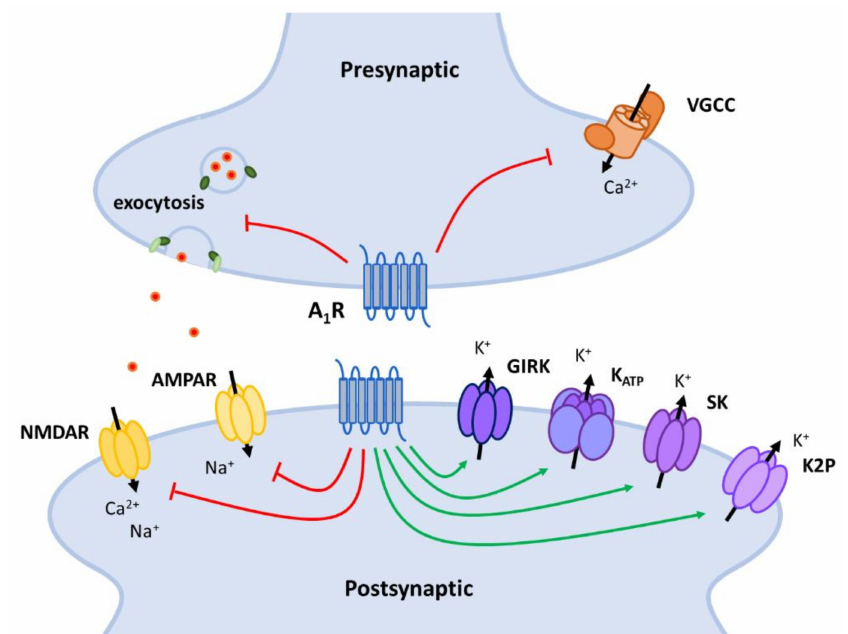
Figure 6. Overview of the pre- and postsynaptic targets of the adenosine A 1 receptor (A 1 R) through which it mediates its main inhibitory neuromodulatory effects; hyperpolarization via activation of K + channels and suppression of synaptic transmission via inhibition of voltage-gated Ca 2+ channels (VGCCs) and proteins involved in exocytosis. AMPAR: AMPA receptor; NMDAR: NMDA receptor; GIRK: G protein-coupled inwardly rectifying K + channel; K ATP : ATP-sensitive K + channel; SK: small conductance Ca 2+ -activated K + channel; K2P: two-pore domain K + channel. Funding: During the writing of this review, Jeroen Spanoghe was supported by a project grant from the “Fonds voor Wetenschappelijk Onderzoek” (FWO), grant number G042219N. Conflicts of Interest: The authors declare no conflict of